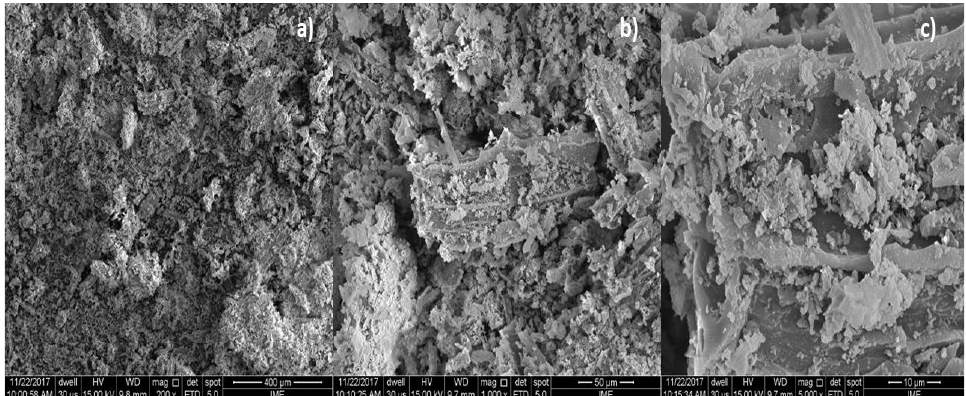
Figure 9. SEM of hydro-chars obtained by hydrothermal processing of corn stover at 250 °C with a biomass/H 2 O ratio of 1:15 after 240 min using a reactor of 18.75 L (MAG: 200× ( a ); MAG: 1000× ( b ); biomass/H 2 O ratio of 1:15 after 240 min using a reactor of 18.75 L (MAG: 200 × ( a ); MAG: 1000 × ( b ); MAG: 5000× ( c )). MAG: 5000 × ( c )).